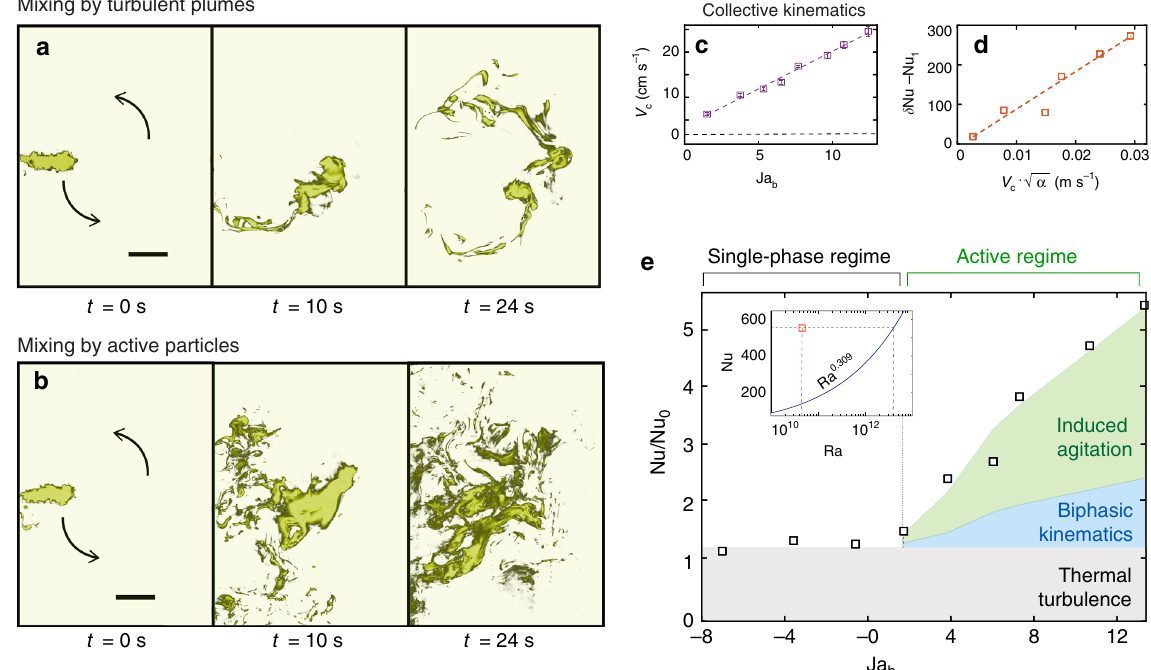
Fig. 3 Modeling of mixing and heat transport mechanisms. Snapshots of mixing of a patch of fl uorescent dye (passive scalar) released in a classical thermal turbulence system and b active biphasic turbulence, at time instants (left to right) 0, 10, and 24 s after injection. In classical thermal turbulence a , the spreading occurs primarily along path of the large-scale circulation (LSC), while in the active biphasic case b , the mixing is fast and occurs across a wide range of scales (see Supplementary Movie 10 and 11 for the comparison). False coloring was adopted based on the intensity of the dye. c Collective LSC velocity V c in the active regime vs. Jakob number Ja b of the bottom plate. The LSC velocity for classical thermal turbulence (black dashed line) is also shown for comparison. d Differential heat fl ux δ Nu — Nu l vs. theoretical estimate of liquid agitation 39 u ′ ¼ V enhancement, Nu l is heat transfer enhancement contributed by biphasic kinematics, and u ′ is the theoretically estimated liquid velocity fl uctuation (r.m.s) based on the measured V c and volume fraction α . e Nusselt number for increasing Jakob number Ja b (see also Suppl. Mat.). The shaded areas show different contributions to the total heat transfer enhancement, namely thermal turbulence (gray), biphasic particle kinematics (blue) and induced liquid agitation (green). The inset compares active particle induced heat transport with the Nu vs. Ra scaling of classical thermal turbulence. Scale bar: 22